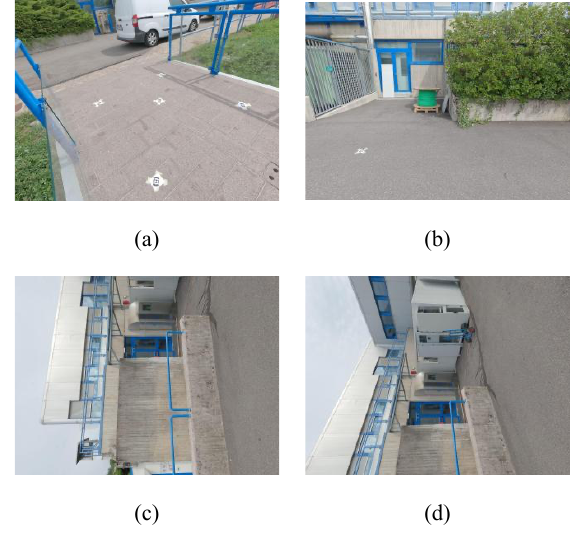
Figure 6: Examples of images acquired with the GoPro HERO 9. The calibration setup (a) and of the surveyed building